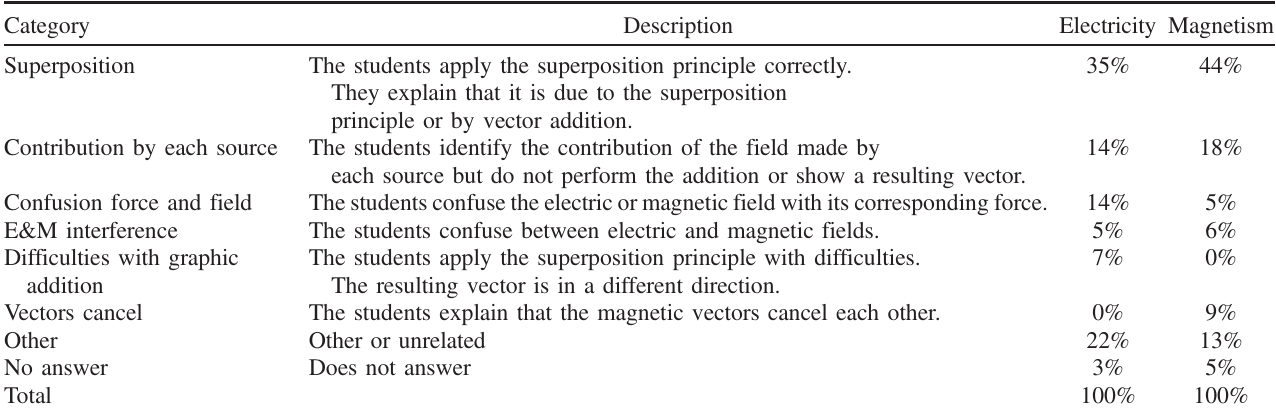
TABLE II. We compare the different ways of applying the principle of superposition that emerged from students ’ drawings and explanations in the electric and magnetic contexts. Category Description